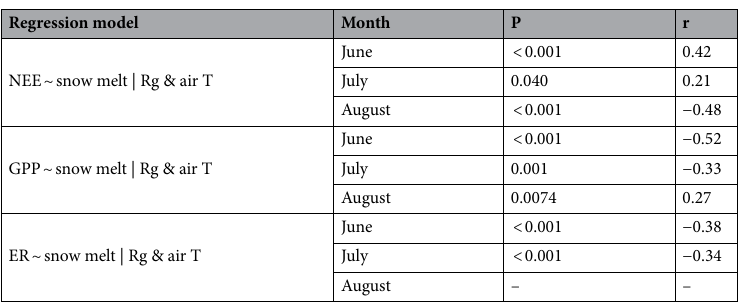
Table 1. Significance (P) and Pearson’s correlation coefficient (r) of the relationships between the indicated monthly median standardized anomalies for June, July, and August retaining site as a unit of variation. Site was retained as the unit of variation by estimating the standardized anomalies by month and site for each of the indicated variables. The anomalies of the indicated variables were regressed with snow depth anomalies using a partial correlation accounting for the anomalies of solar radiation and air temperature, as shown in Fig. 2. The P and r were only included when the P < 0.1 (given that for P > 0.1 we assumed that r is not significantly different from zero), N =